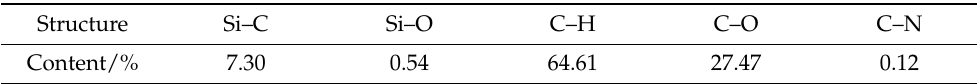
Figure 5. The XPS full spectrum and Si spectrum of EP-POSS.